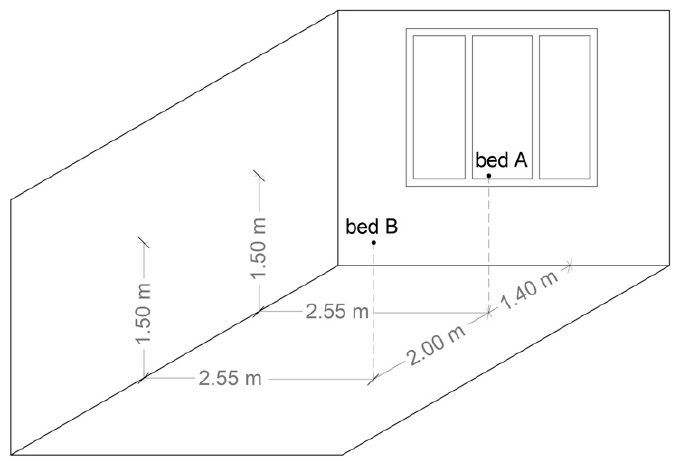
Figure 6. Position of the two points for which PMV and PPD indexes were evaluated.